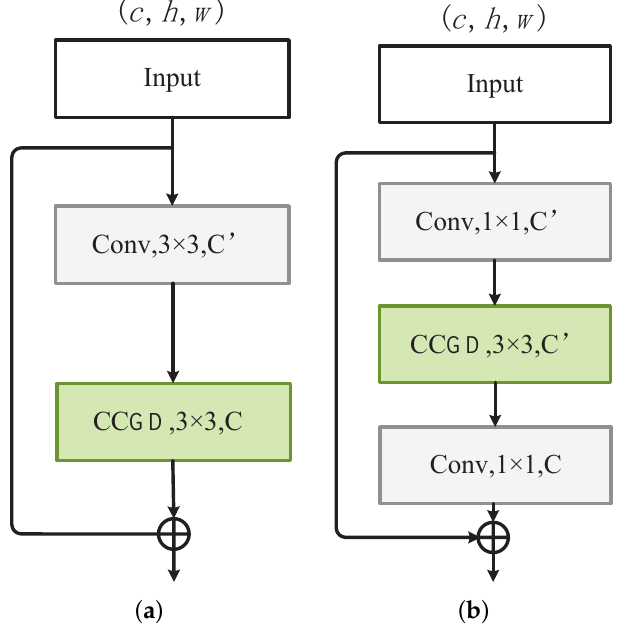
Figure 3. CCGD integrated with different residual block in ResNet: ( a ) basicblock; ( b ) bottlenck